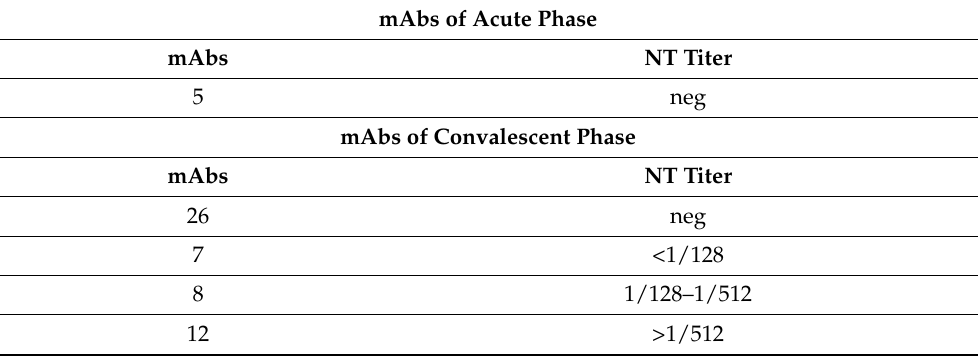
Table 2. Human mAbs tested for neutralizing activity against